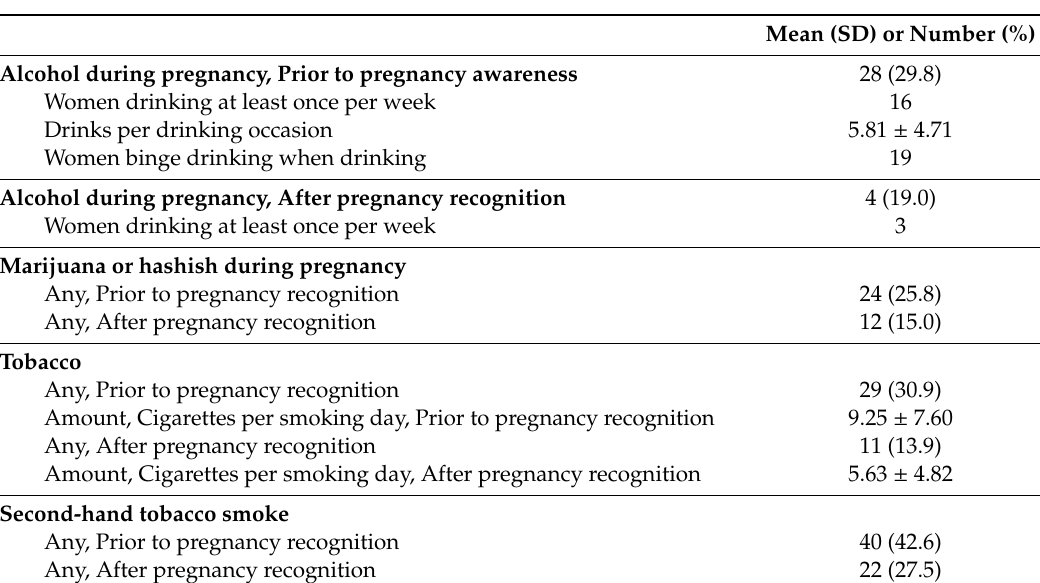
Table 2. Prenatal